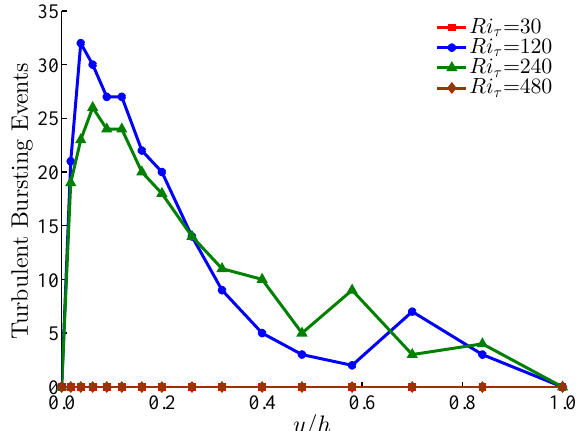
Figure 7. Vertical distribution of turbulent bursting events with dif- ferent Ri τ in the channel ( Re τ = 180). The turbulent bursting events are calculated within 50 non-dimensional